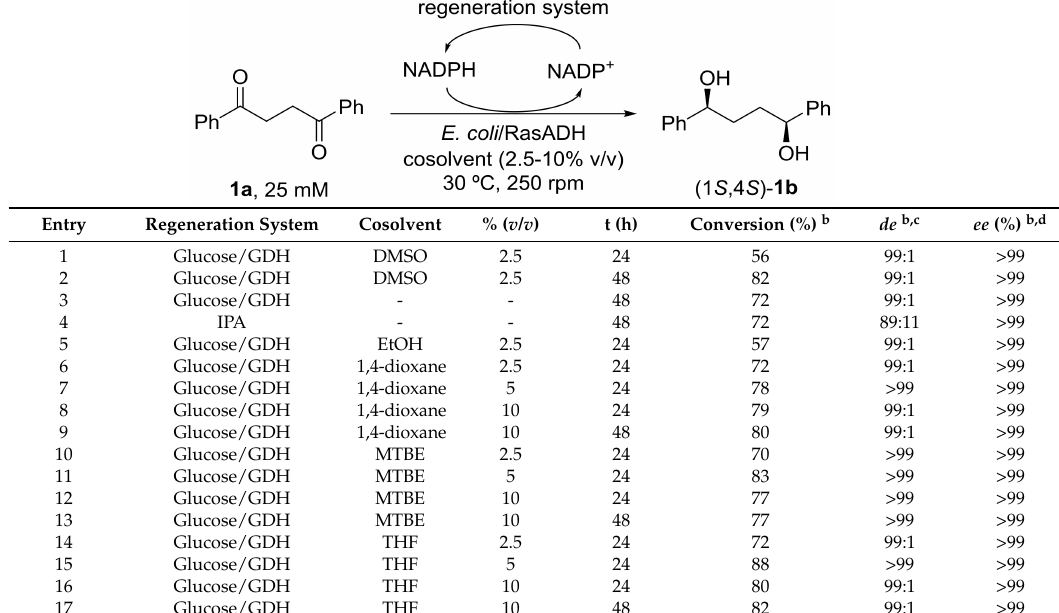
Table 1. Bioreduction of 1,4-diphenylbutane-1,4-dione ( 1a ) using E. coli /RasADH a